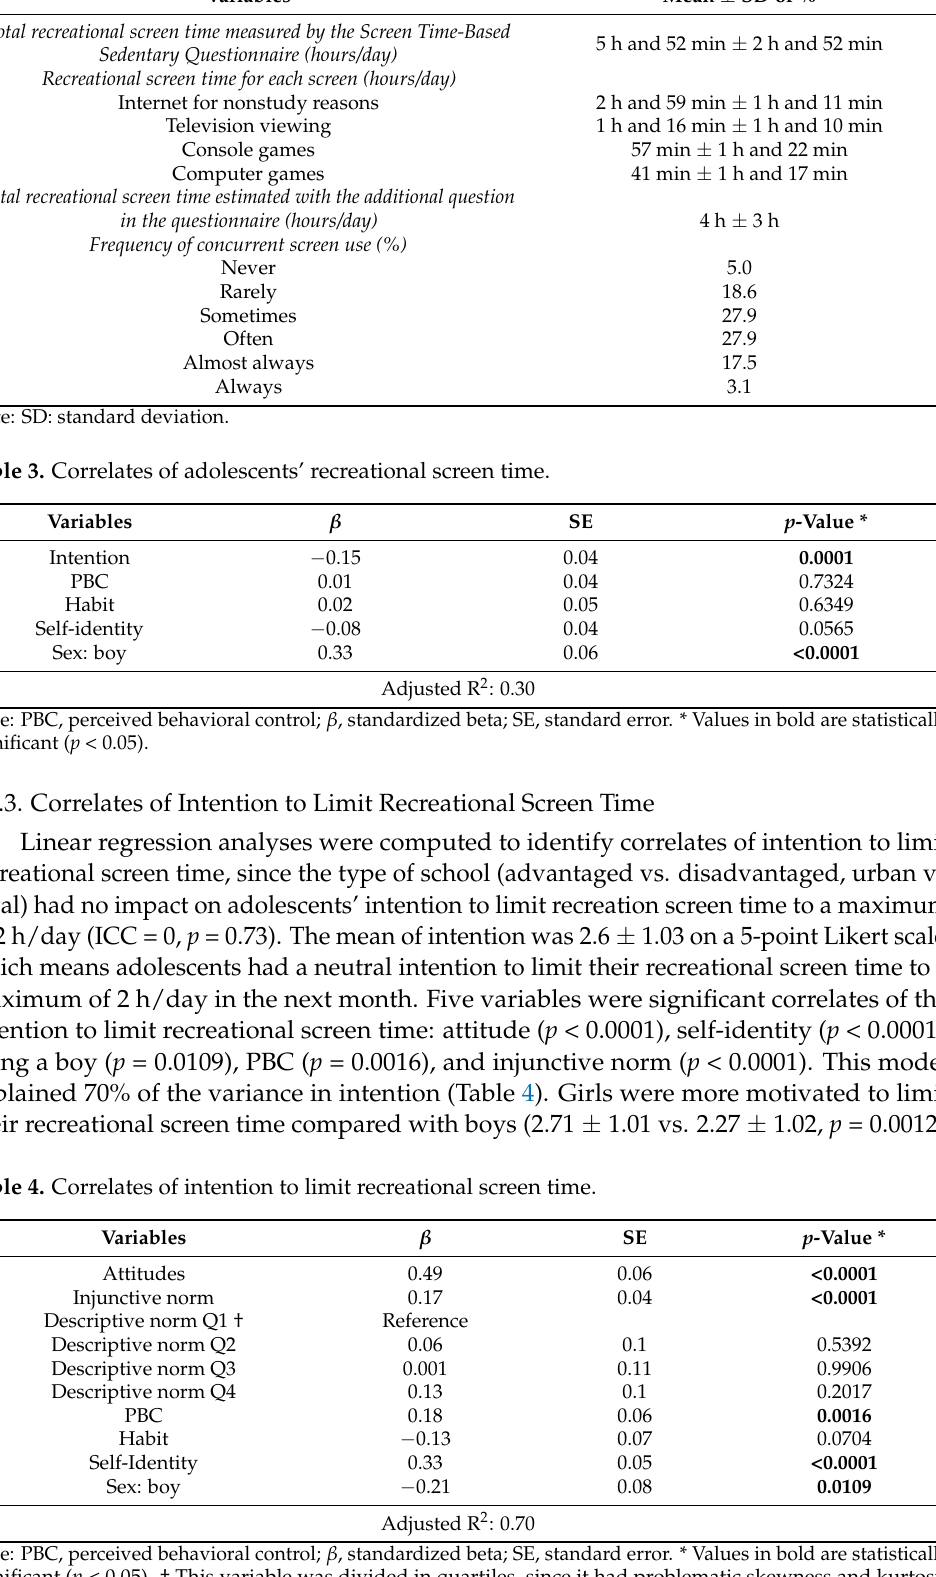
Table 2. Adolescents’ recreational screen time ( n = 258). Variables